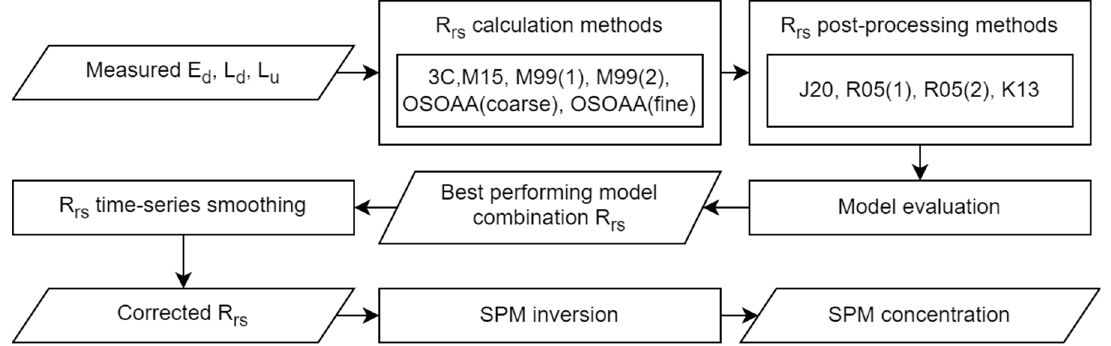
Figure 2. Data processing methodology schematic.